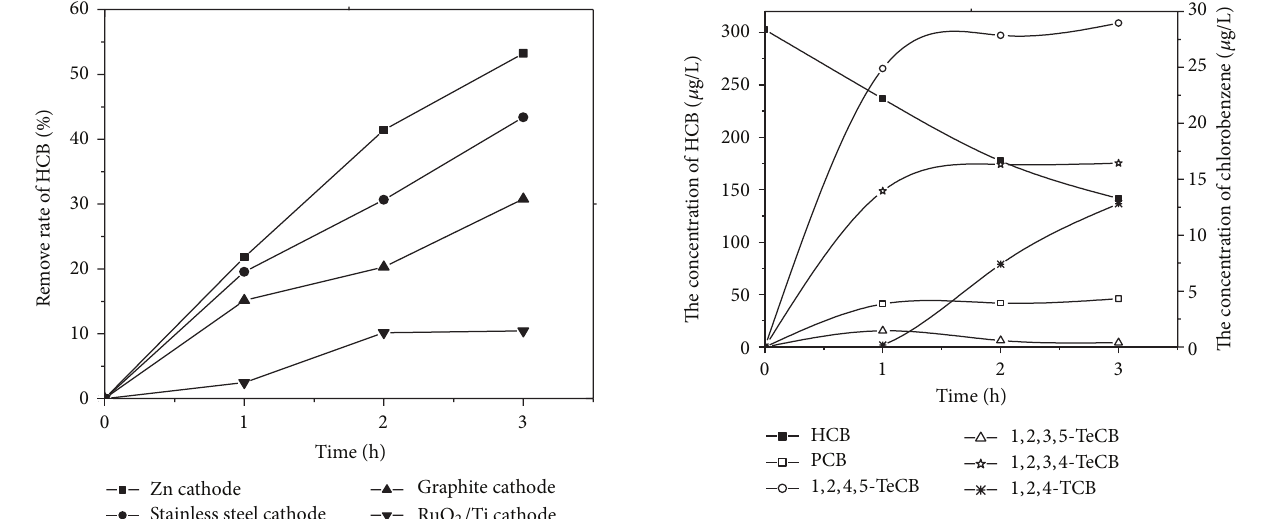
Figure 2: Variation of HCB and its dechlorination intermediates concentration using zinc cathode.